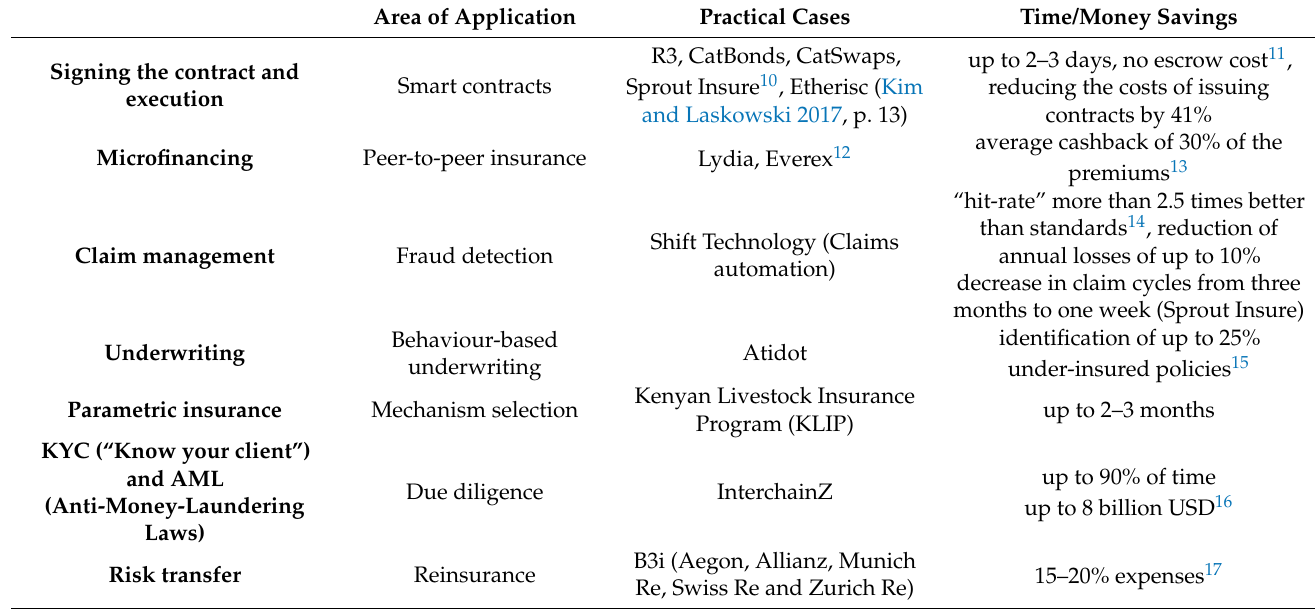
Table 3. DLT-related cost and time savings for insurance